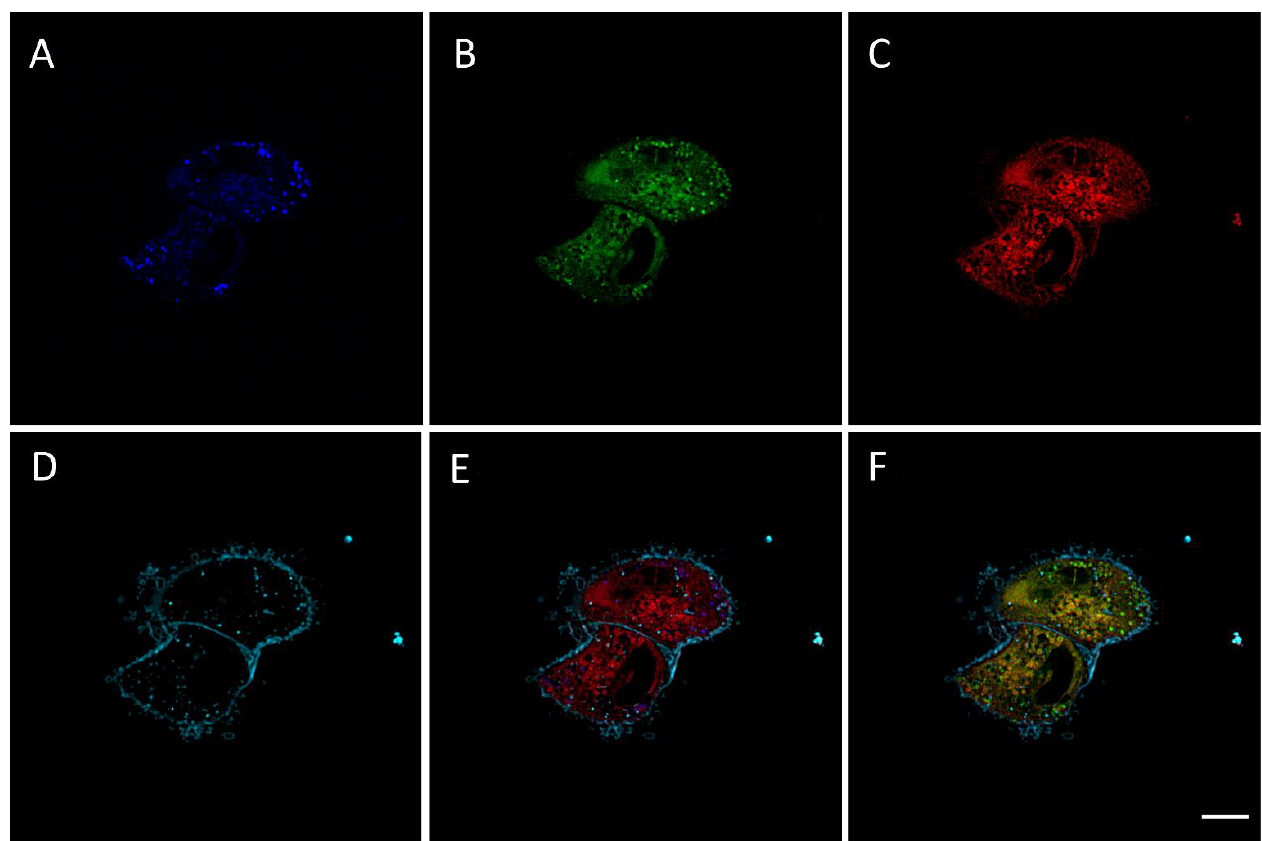
Figure 2. Confocal imaging of RM-581-Fluo in PC-3 cells. Representative image from confocal microscopy experiments in PC-3 cells at 60× magnification showing one focal plane. Cells treated for 2 h with 15 µM of RM-581-Fluo prior microscopy. ( A ) Cellular localization of RM-581-Fluo in blue (λex 405 nm, λem 460/50 nm); ( B ) cellular localization of RM-581-Fluo in green (λex 405 nm, λem 525/50 nm); ( C ) cellular localization of ER-Tracker in red (λex 561 nm, λem 593/40 nm); ( D ) cellular localization of Cell-mask in cyan (λex 642 nm, λem 700/75 nm); ( E ) merged images A, C, and D showing localization of RM-581-Fluo (blue), ER tracker (red) and Cell-mask (cyan); ( F ) merged images B, C, and D showing localization of RM-581-Fluo (green), ER tracker (red), Cell-mask (cyan), and colocalization of RM-581-Fluo and ER-Tracker (yellow). Scale bar: 10 µm. Three additional confocal images from a second experiment with RM-581-Fluo in PC-3 cells are shown in Figure S3, Supplementary Materials).